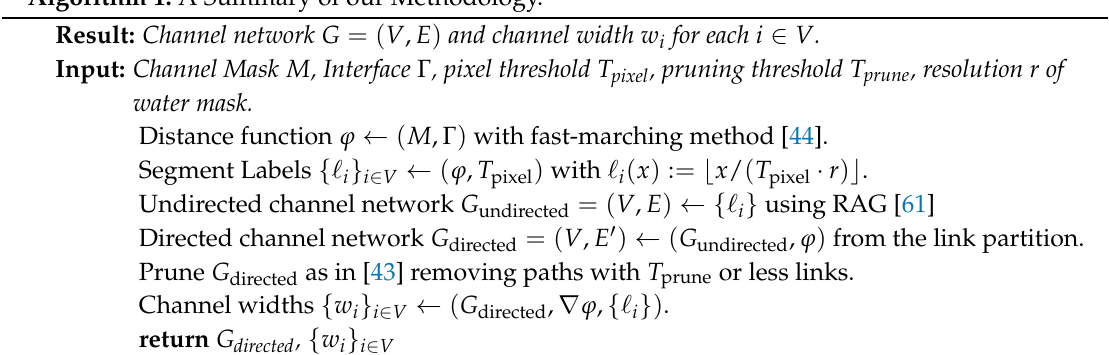
Algorithm 1: A Summary of our